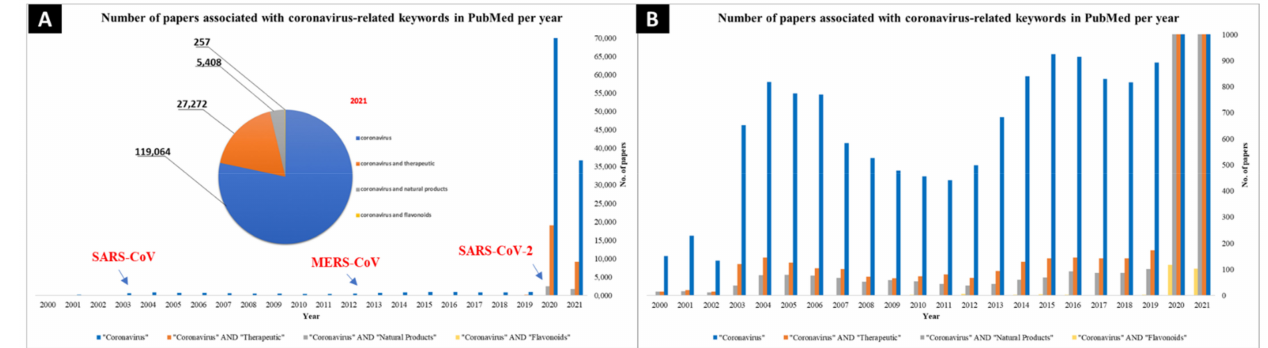
Figure 2. Comparison of the number of papers per year dealing with the words “coronavirus”, “coronavirus and ther- apeutic”, “coronavirus and natural products” and in the inset, total number of papers used keywords published from 2000 to 2021. ( A ) Bar graph to scale to account for all relevant papers published from 2020–2021, with indications at each major coronavirus outbreak and a pie chart showing the relative number of papers per key phrase. ( B ) Zoomed-in figure to account for low number of hits from 2000–2019 as well the low number of papers dealing with “coronavirus and flavonoids”. (Source: PubMed Database (https://pubmed.ncbi.nlm.nih.gov/), accessed on 3 June